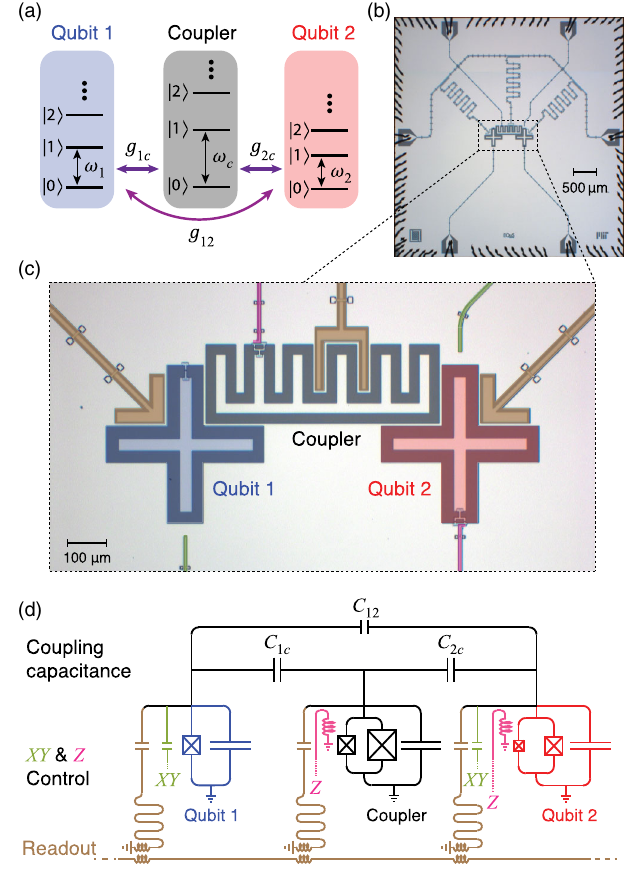
FIG. 1. (a) Schematic diagram of a pairwise interacting three- body system. Each constituent body has anharmonic multiple energy level structure. (b),(c) Experimental realization of a three- body system in superconducting circuits. (d) Circuit schematic. In (c), false colors (blue, red, pink, green, and brown) are used to indicate the corresponding circuit components in